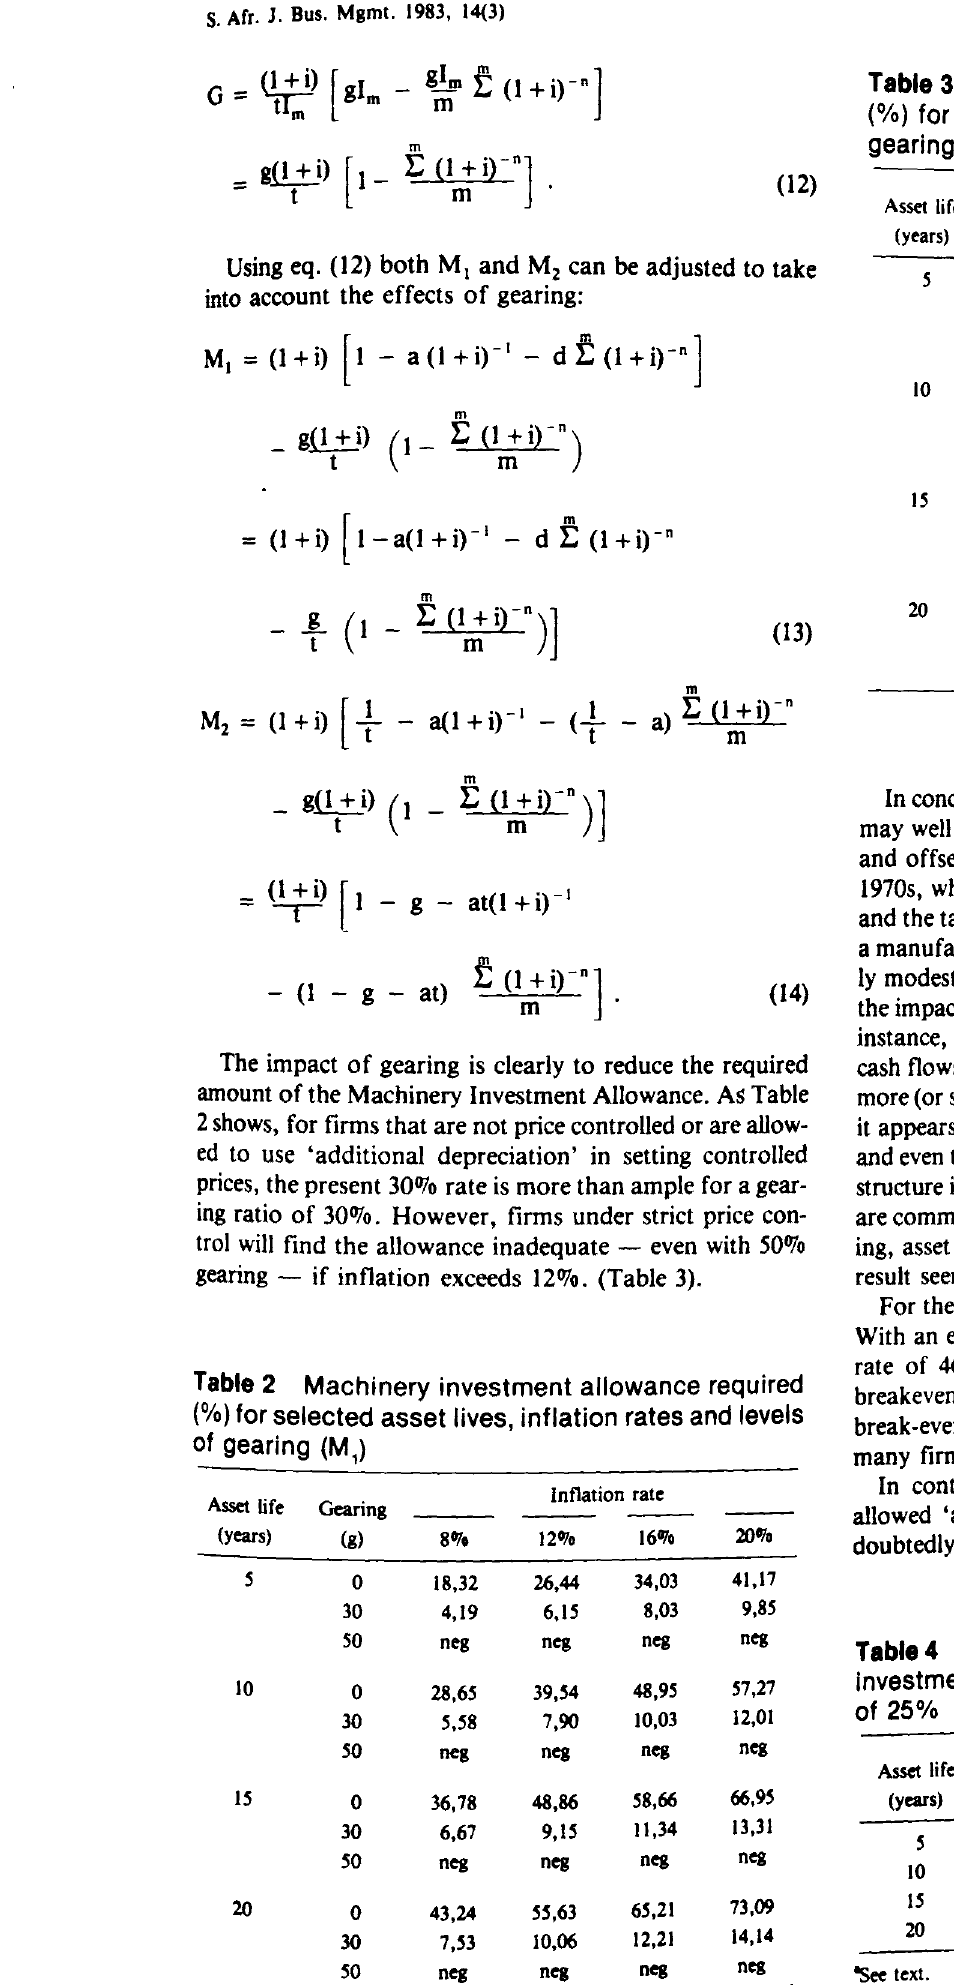
investment allowance of 30% and initial